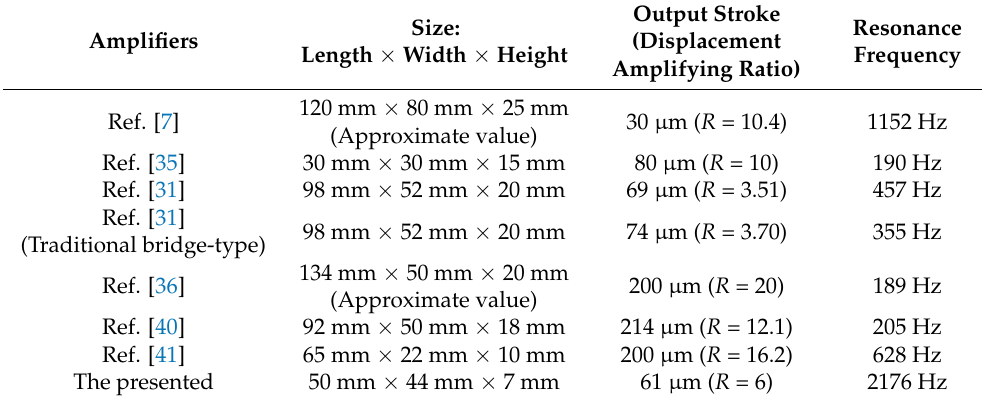
Table 5. Comparison on the static and dynamic performances of different amplified piezoelectric ac-